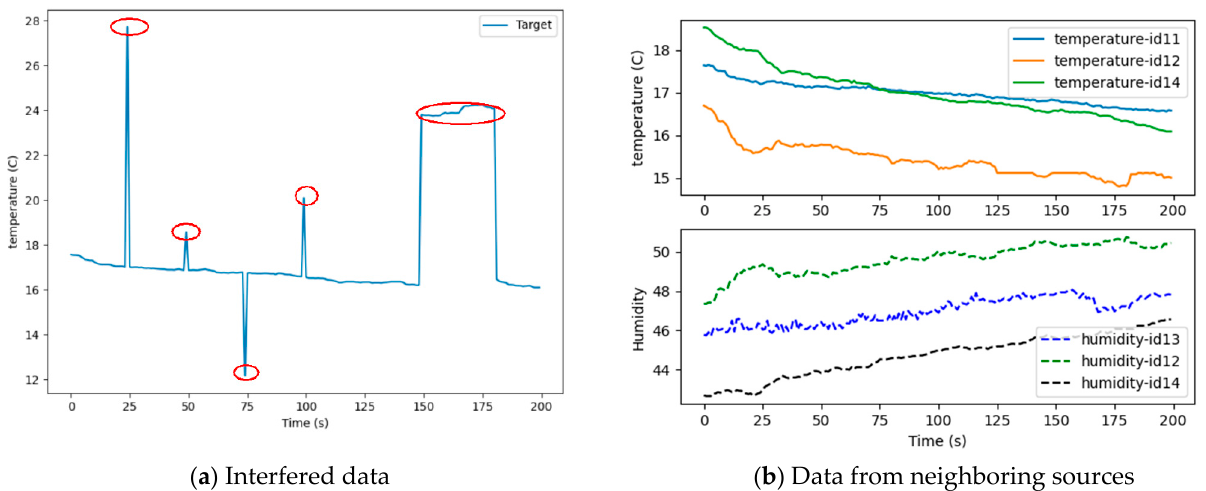
Figure 16. Data visualization. ( a ) Interfered data. ( b ) Data from neighboring sources.